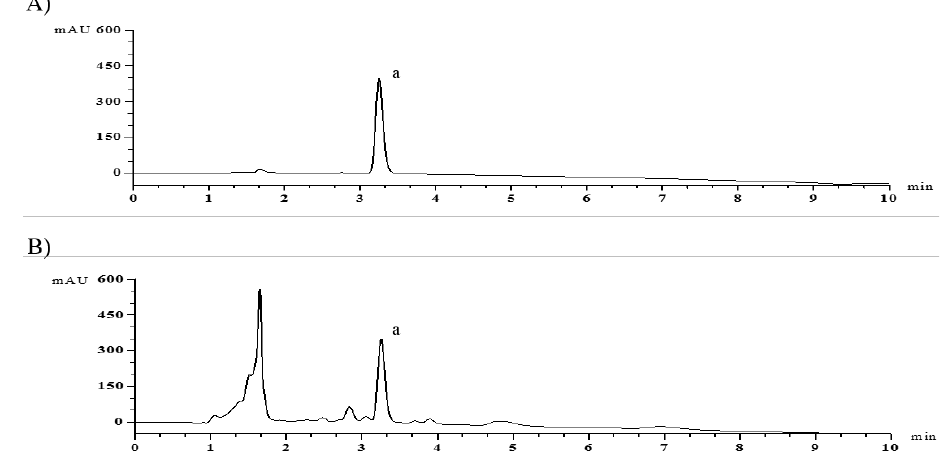
Figure 5. HPLC analysis of allantoin in the yam extract: ( A ) allantoin as a standard compound, and ( B ) allantoin in the water extract. a, allantoin (retention time: 3.253 min).